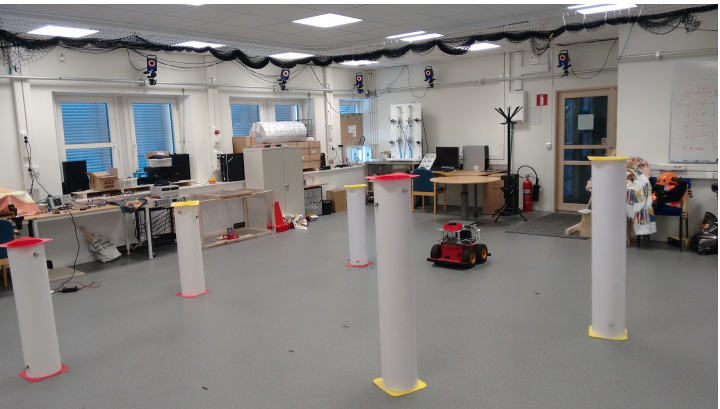
Figure 4. Setup of a typical calibration experiment, comprising five landmarks (white cylinders) and the robot-sensor system of Figure 3 moving among the landmarks.